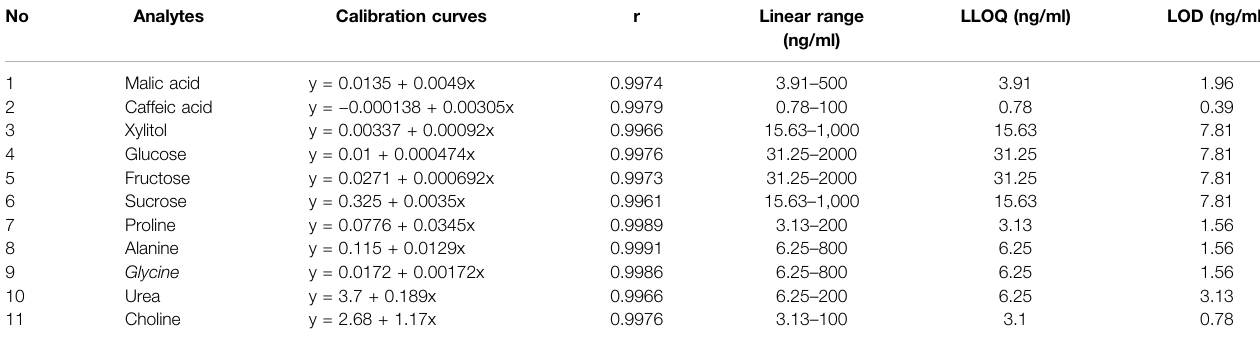
TABLE 1 | Calibration curves, lower limit of quantitation (LLOQ), and lower limit of detection (LOD) of 11